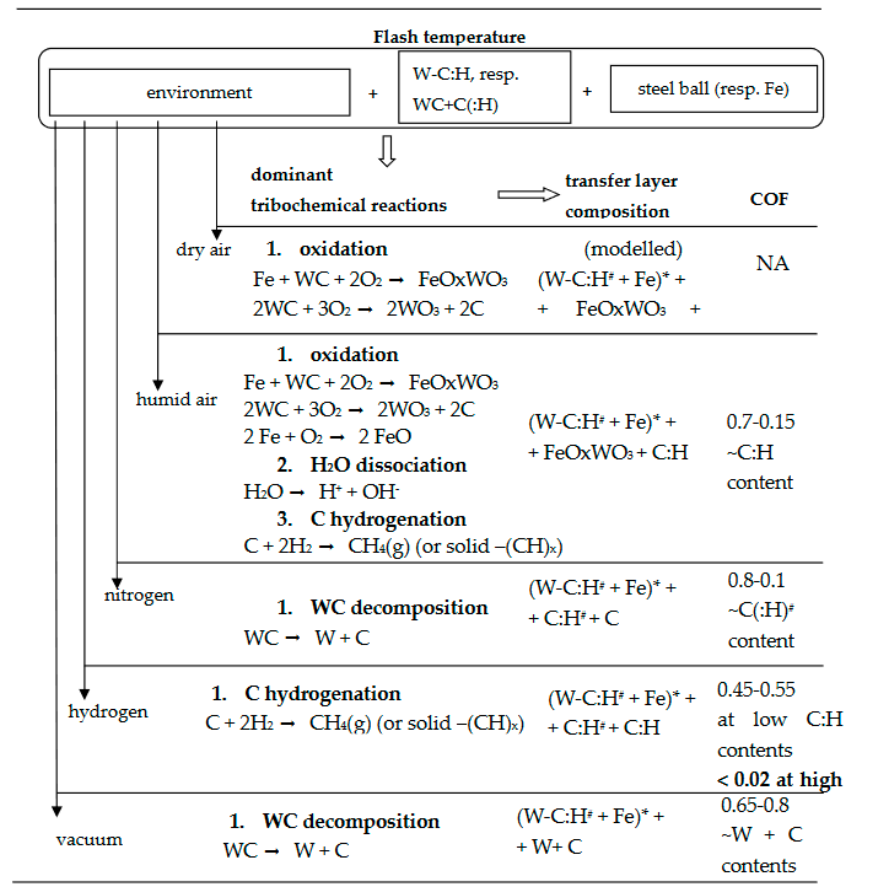
Figure 23. Summary of mechano(tribo)chemical reactions during friction in the studied steel ball/W- C:H coating in different environments and resulting transfer layer compositions vs. obtained coeffi- cients of